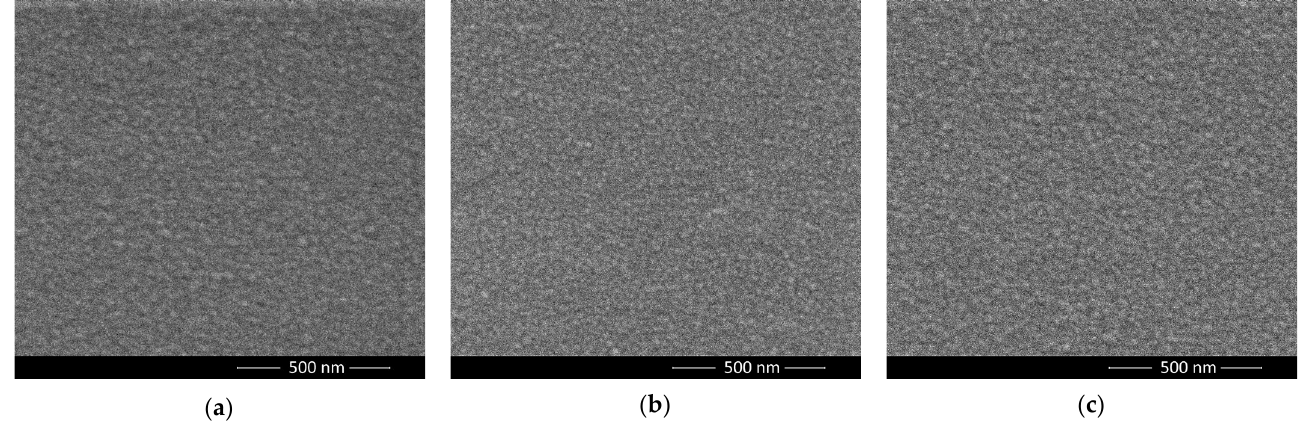
Figure 7. Surface morphology of the deposited layer when using the HiPIMS power supply and for the deposition times of ( a ) 5 min, ( b ) 10 min, and ( c ) 15 min. All the images in Figures 6 and 7 were obtained with the same magnification.